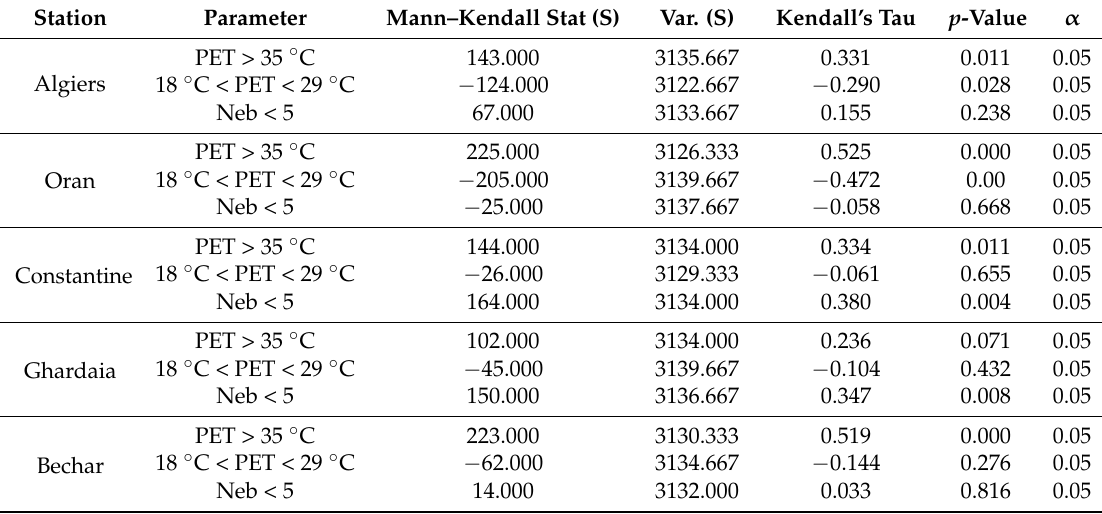
Table 4. Annual Occurrence evolution of hot (PET > 35 ◦ C), acceptable (18 ◦ C < PET < 29 ◦ C)